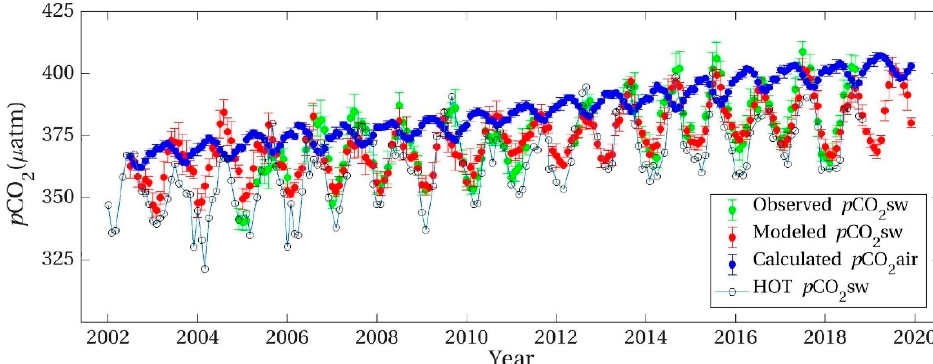
Figure 8. Seasonal WHOT non-equilibrium oscillations in simultaneous p CO 2 measurements in seawater and air [43,45] (y-axis divisions 5 μ atoms p CO 2 ) showing converse values suggesting transfer of CO 2 to air in autumn and, more strongly from air to seawater in spring. Peak and minimum seawater surface temperatures were 1–2 months after mid-summer and mid-winter with ranges of about 4 K, twice that modelled for Hawaii in Figure 5 and Table 3.